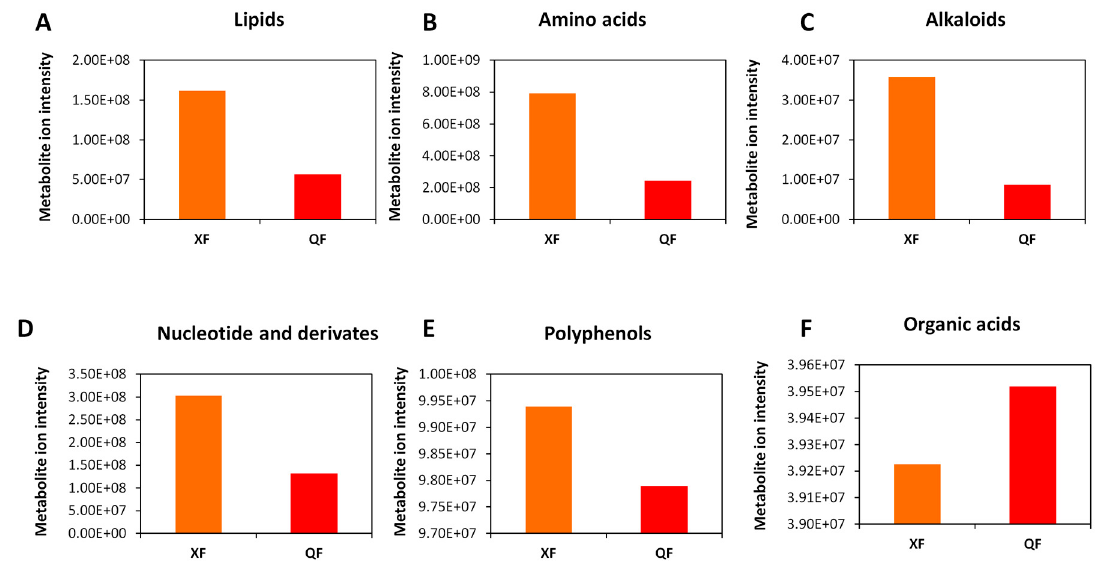
Figure 5. Comparison of the total ion intensity of various classes of metabolites between fruits from Xinjiang (XF) and Qinghai (QF). ( A ) Lipids, ( B ) amino acids, ( C ) alkaloids, ( D ) nucleotides and derivatives, ( E ) polyphenols and ( F ) organic acids. Bars represent the sum of ion intensity of all metabolites belonging to each class.